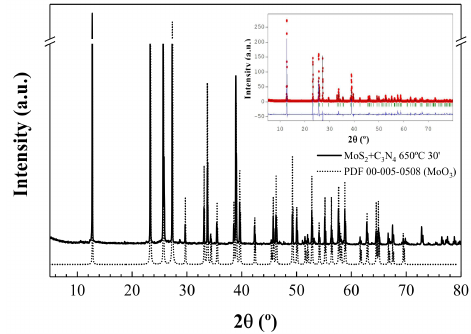
Figure 2. X-ray powder diffraction patterns for the end product upon treatment at 650 ◦ C (solid line) and for orthorhombic α -MoO 3 (dotted line). Inset: Rietveld refinement results, using FullProf